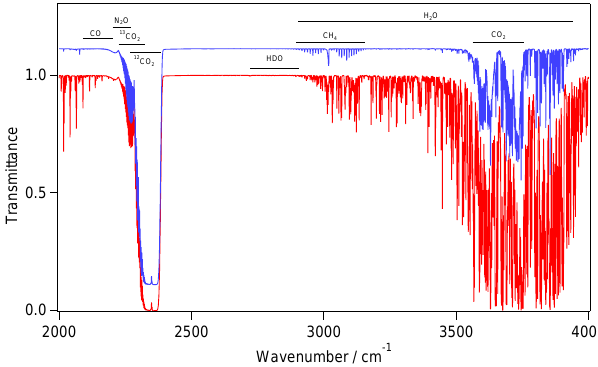
Fig. 1. The mid-infrared absorption spectrum of clean air in a 24 m cell. Red: undried air, blue: dried air. Positions of main absorption bands of target gases CO 2 , CH 4 , CO and N 2 O are shown. More detail of individual regions is shown in Fig.